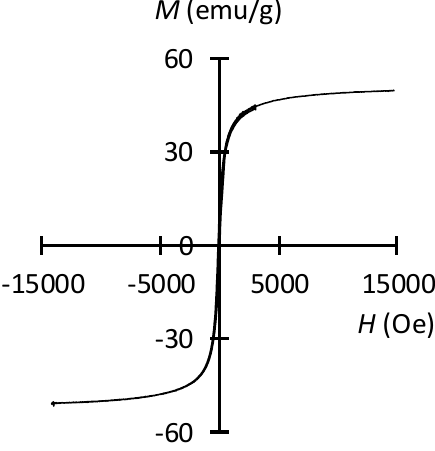
Figure 4. Magnetization curve of the MDC sponge at room temperature.